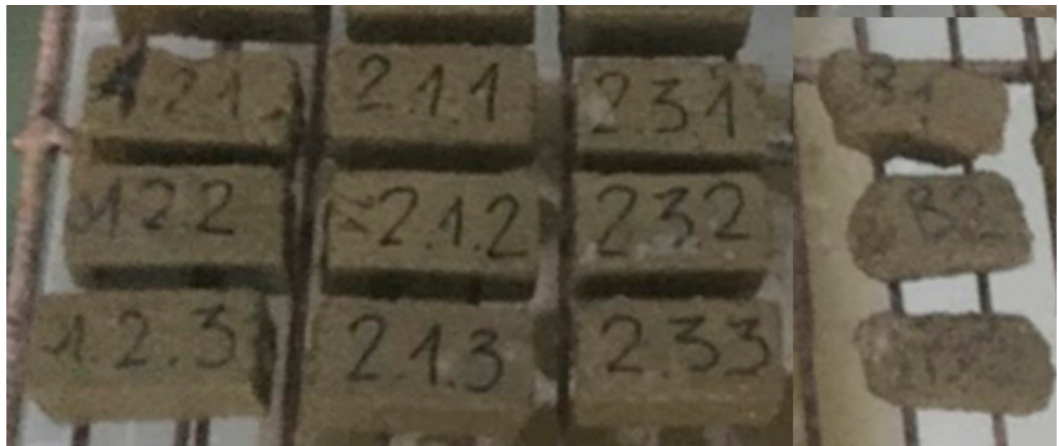
Figure 4. Glauconite clay mortar samples before the water immersion. From the left: CM-1, CM-2, CM-3, CM-0.